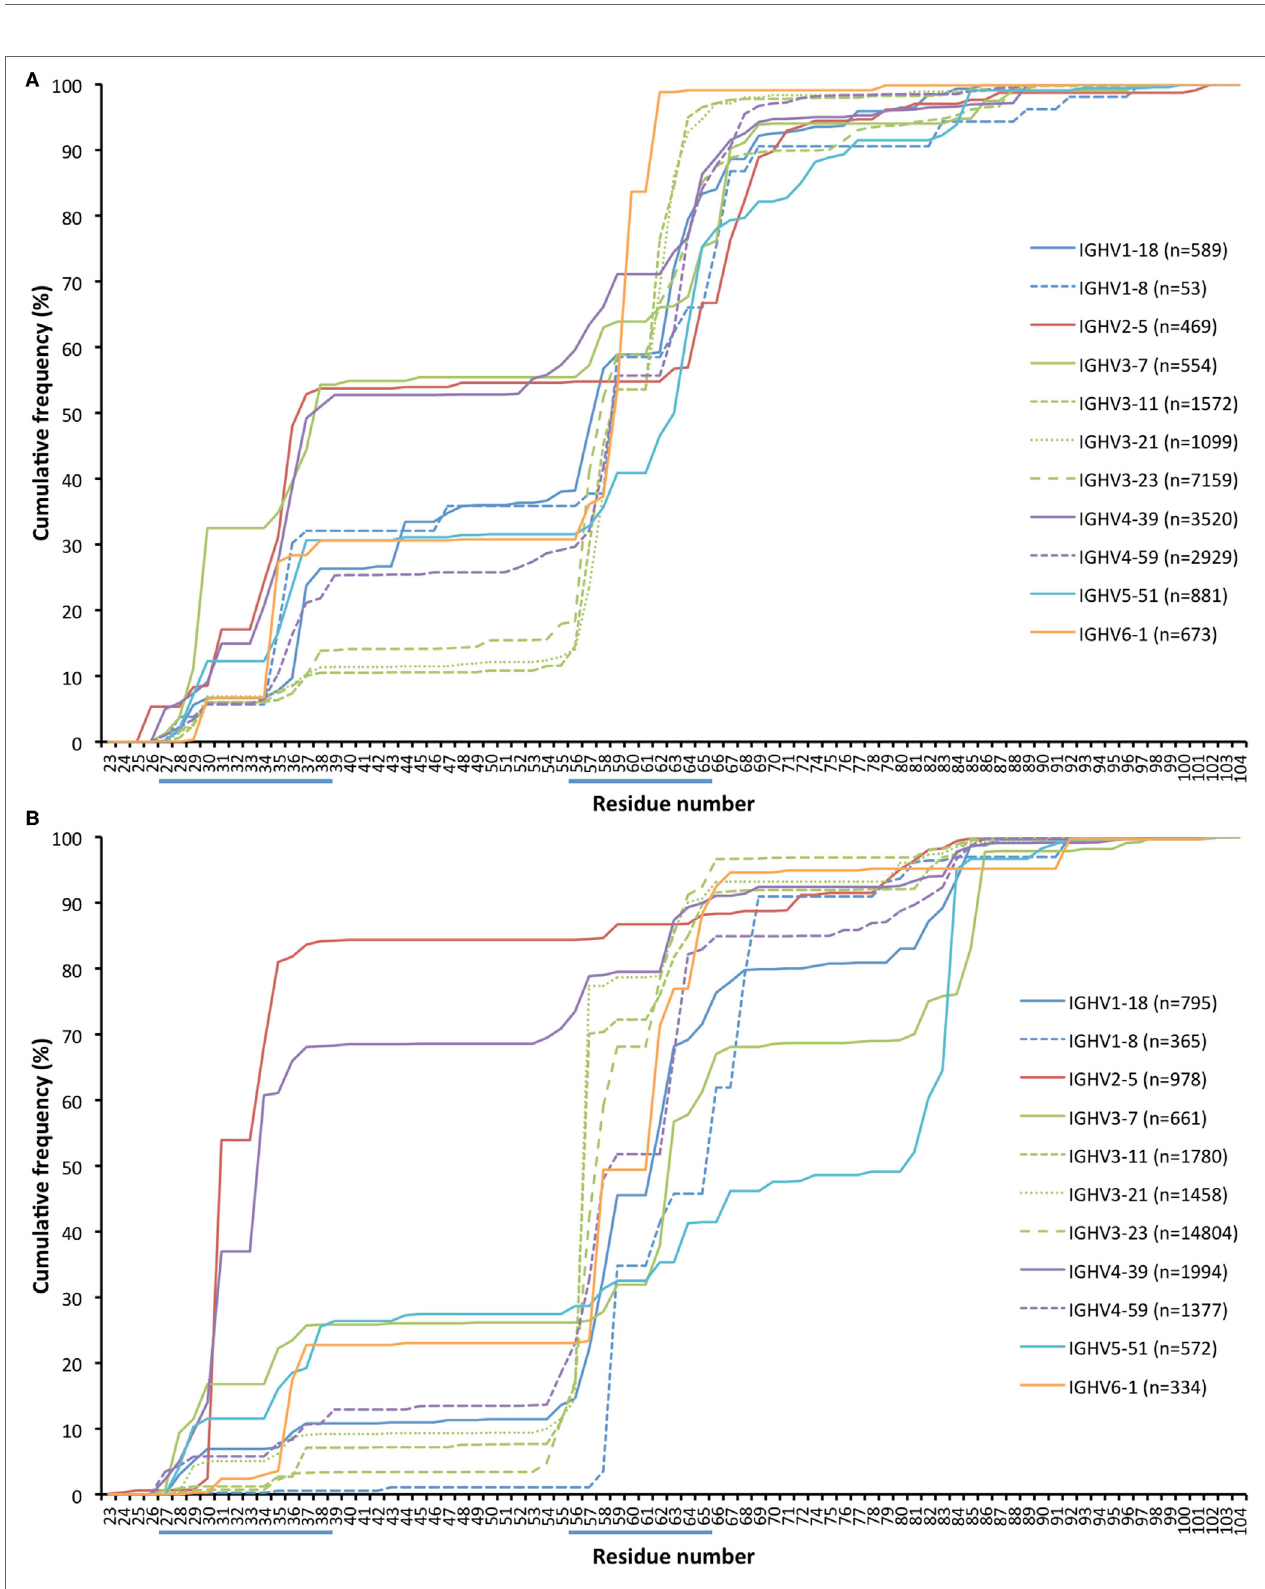
FigUre 12 | Cumulative frequency of in-frame codon insertion (a) and deletion (b) (as calculated by IMGT HighV-QUEST) in rearranged genes derived from a set of germline genes (irrespective of allele origin). The occurrence of such events in genes derived from additional germline genes, not representing the core genes investigated in this study, are shown in Figure S5 in Supplementary